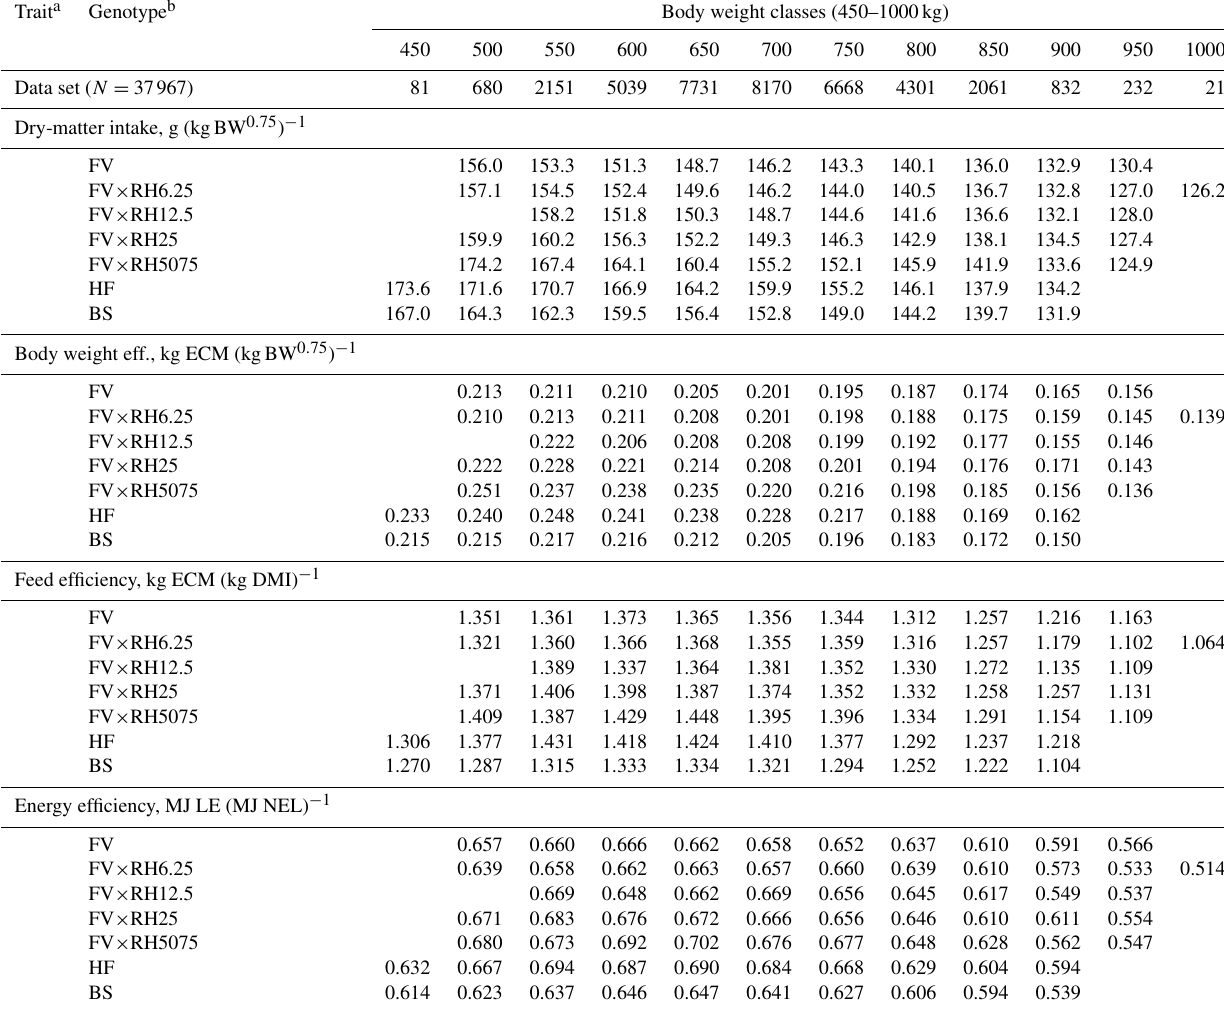
Table 2. Effect of genotype × body weight on dry-matter intake per kilogram body weight and efficiency parameters (least squares means). Trait a Genotype